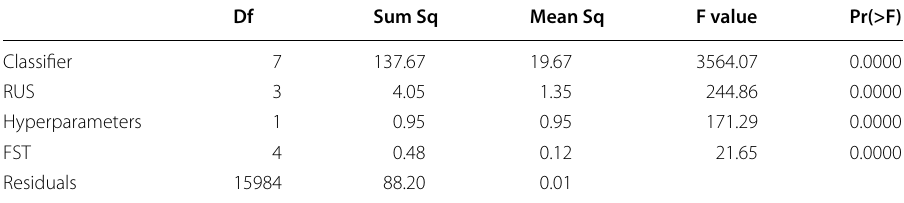
Table 22 ANOVA for classifier, RUS, hyperparameters and FST as factors of performance in terms of AUC Df Sum Sq